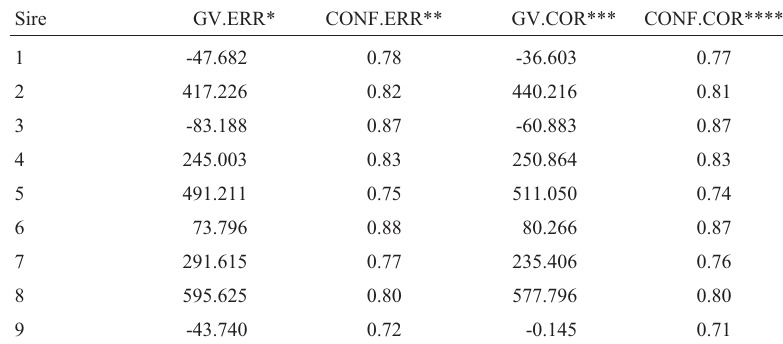
Table IV - The genetic values of sires altered after the second